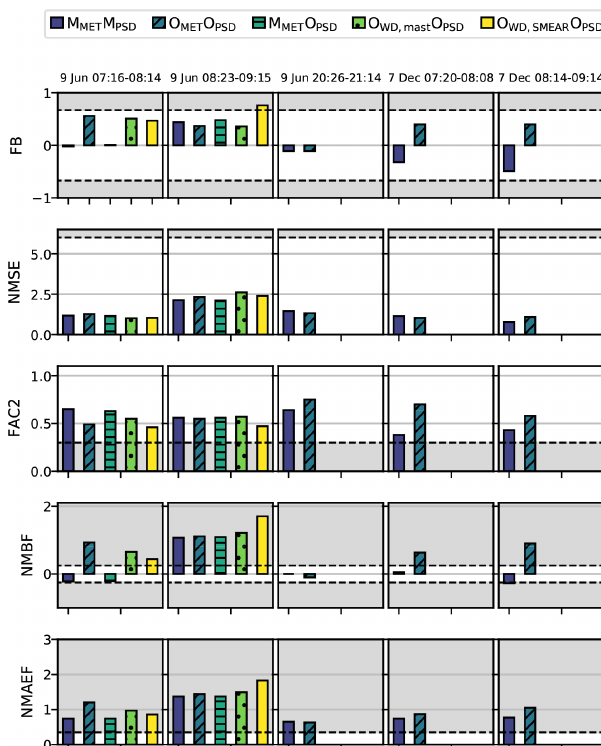
Figure 4. Model performance for the horizontal distribution of N tot using the FB, NMSE, FAC2, NMBF and NMAEF performance measures. The grey area indicates that the value exceeds the ac- ceptance criteria given in Table 5. See Table 4 for the simulation names. Note that during the summer evening and winter morning, only two simulations have been conducted.